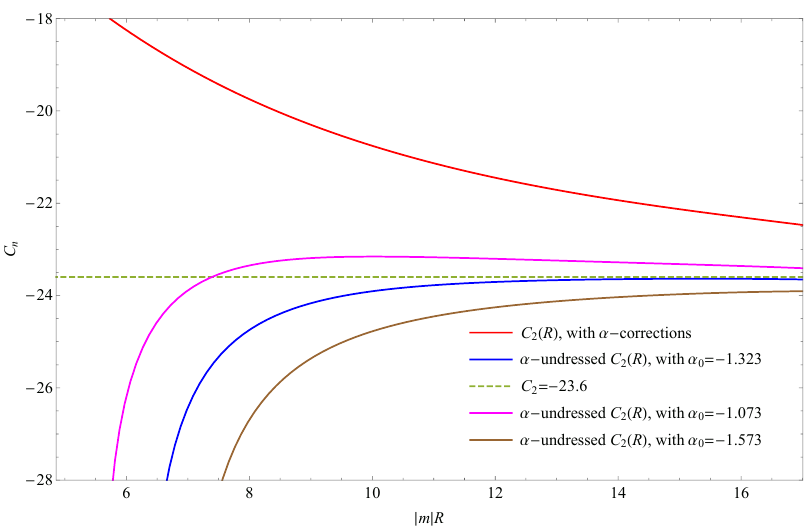
Figure 9 . Plots of TFFSA data for C 2 ( R ) (in red line), and the plots of (3.18) against ˜ R (TTbar- undressed C (0) ( R ) ), with few sample values of α 0 2